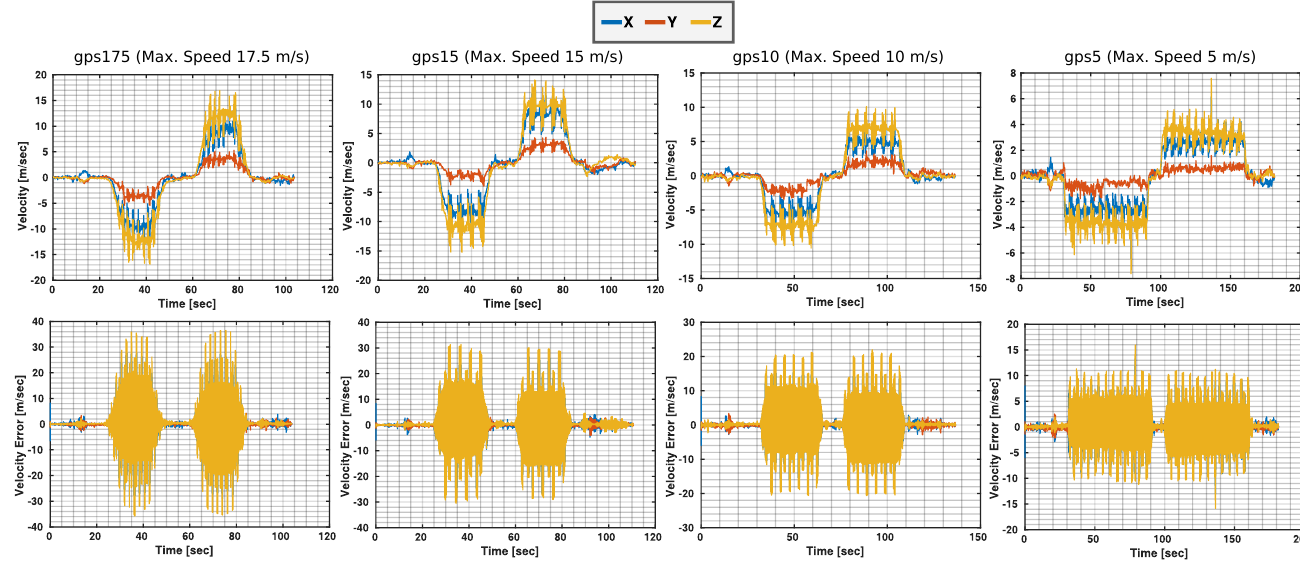
Figure 9. ( Top ): Fast Flight velocity profile validation with the top speed of each sequence. ( Bottom ): velocity error states in the ES −